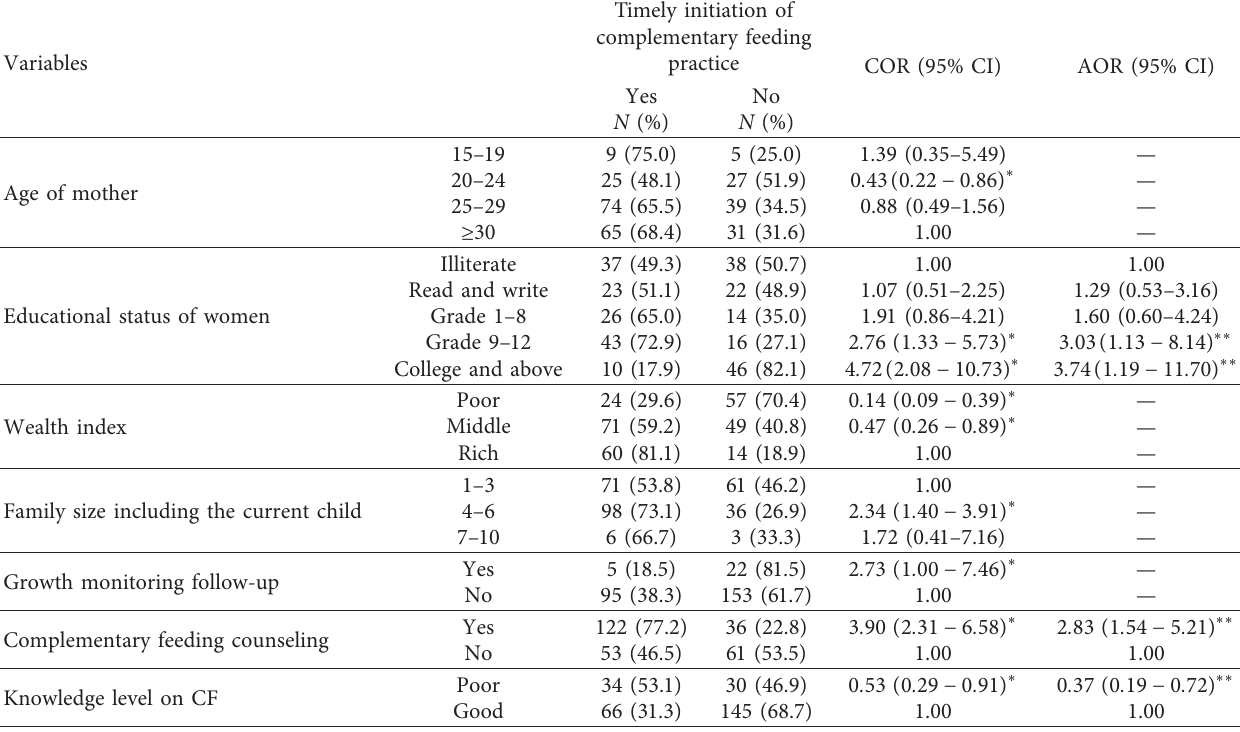
Table 2: Factors associated with timely initiation of complementary feeding among mothers of children aged 6–24 months in Dessie Referral Hospital, Northeast Ethiopia, 2019 ( n � 275).